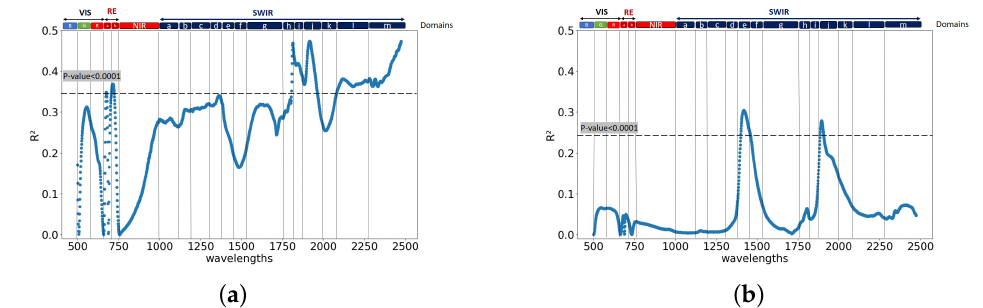
Figure 13. Determination coefficient of linear regressions for each wavelength when considering only plots A and C (left) or only plot B (right). The spectral domains defined in Table 6 are reported above the graph. ( a ) Plots A and C. ( b ) Plot